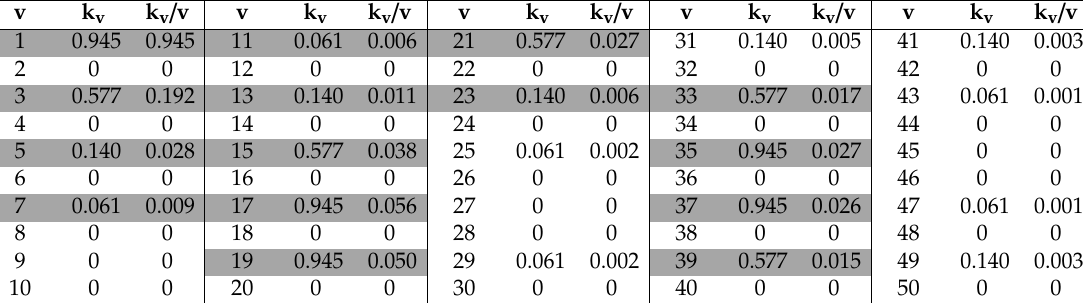
Table A3. Harmonic winding factors of the three-phase